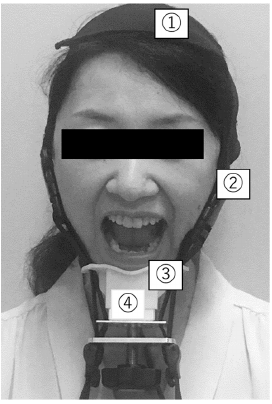
Figure 2. Jaw-opening force measurement (jaw-opening stenometer). ① Head-encircling belt; ② Two straps to secure the mandible to the head-encircling belt; ③ Chin cap; ④ Dynamometer to assess jaw-opening strength.